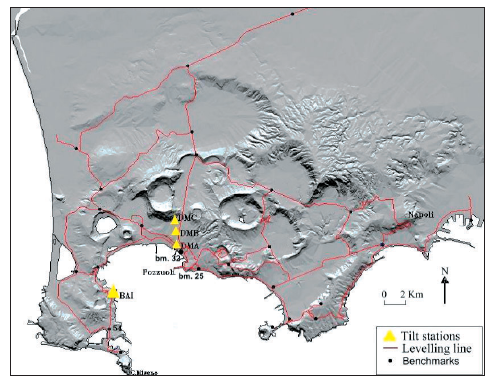
Fig. 3. Levelling line and tilt stations belonging to OV Phlegraean surveillance